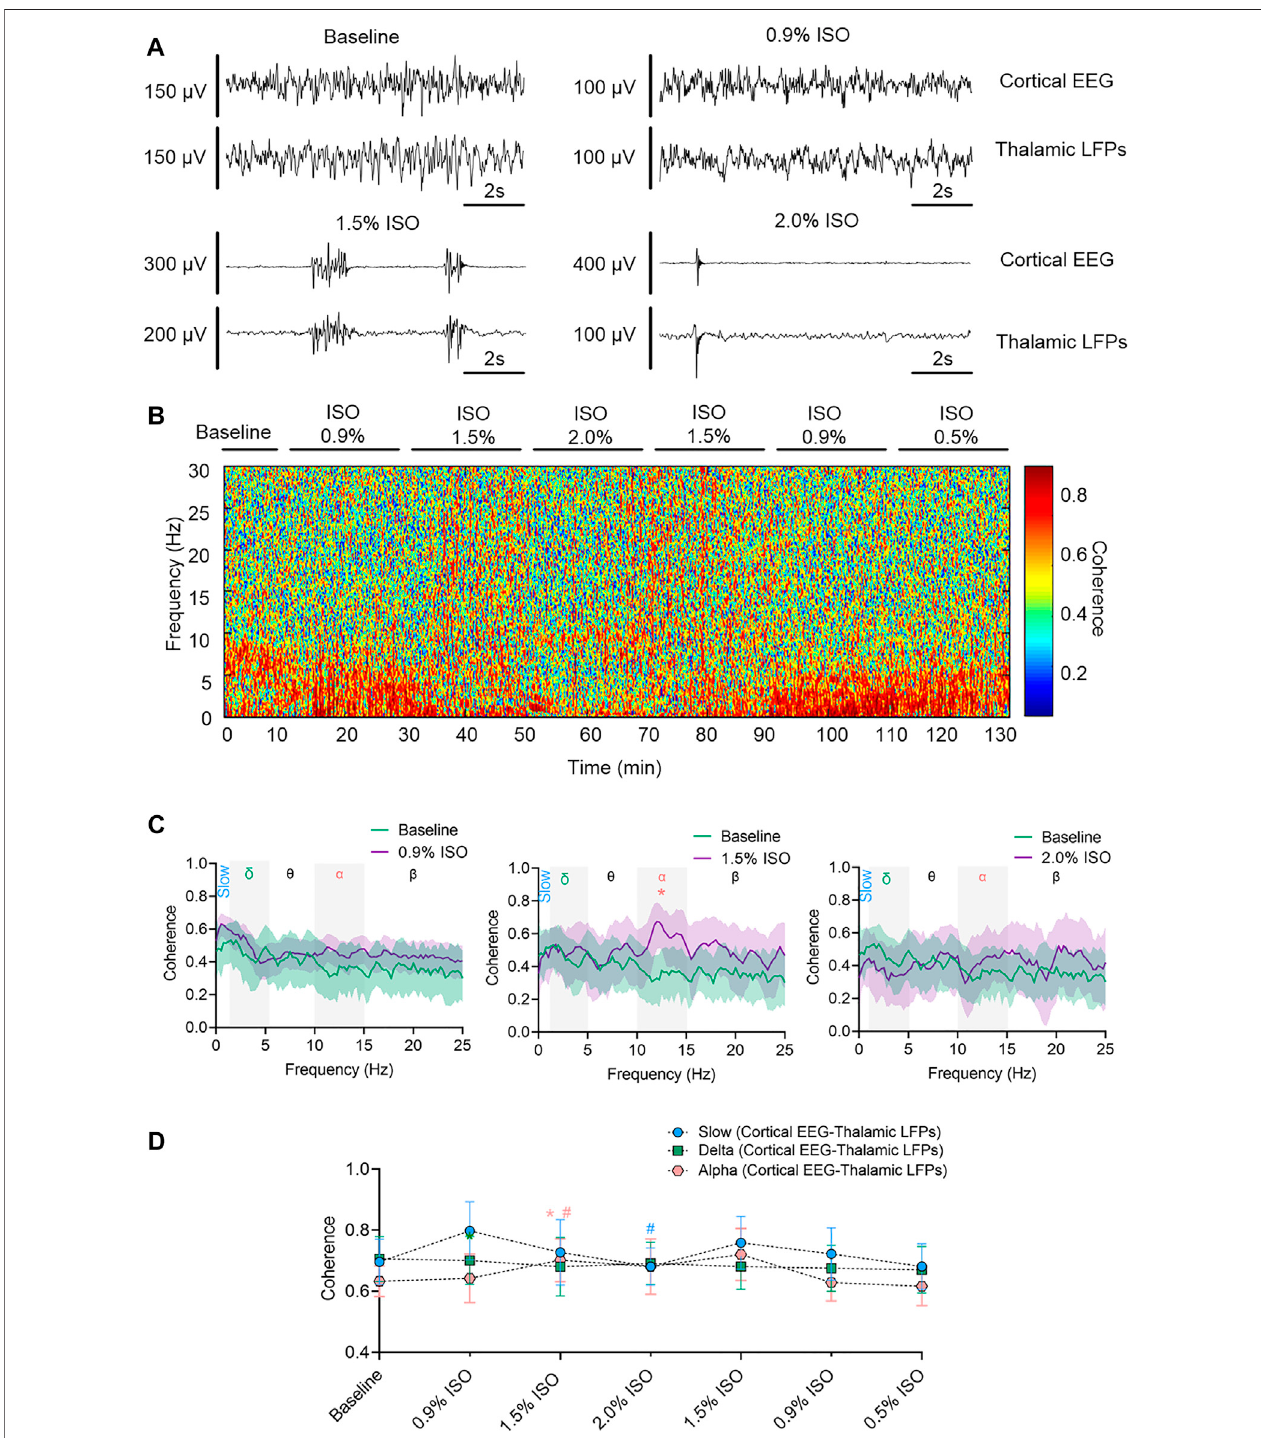
FIGURE3| Thalamocorticalsynchronizationunderiso fl uraneanesthesia. (A) RepresentativerawtracesofcorticalEEG(upper)andthalamicLFPs(lower)withinthe sameperiod. (B) RepresentativecoherogrambetweencorticalEEGandthalamicLFPs. (C) CoherencebetweencorticalEEGandthalamicLFPs.Shadingindicates95% CI. (D) CoherencebetweenthalamicLFPsandcortexEEG.Comparisonsarebasedontherepeated-measuresANOVAforallexperimentsfollowedbyTukey ’ sposthoc test: * p < 0.05 vs. baseline. Frequency oscillations: slow (0.5 – 1 Hz), delta (1 – 5 Hz), and alpha (9 – 14 Hz). LFPs, local fi eld potentials; CI, con fi dence interval; and ISO, iso fl